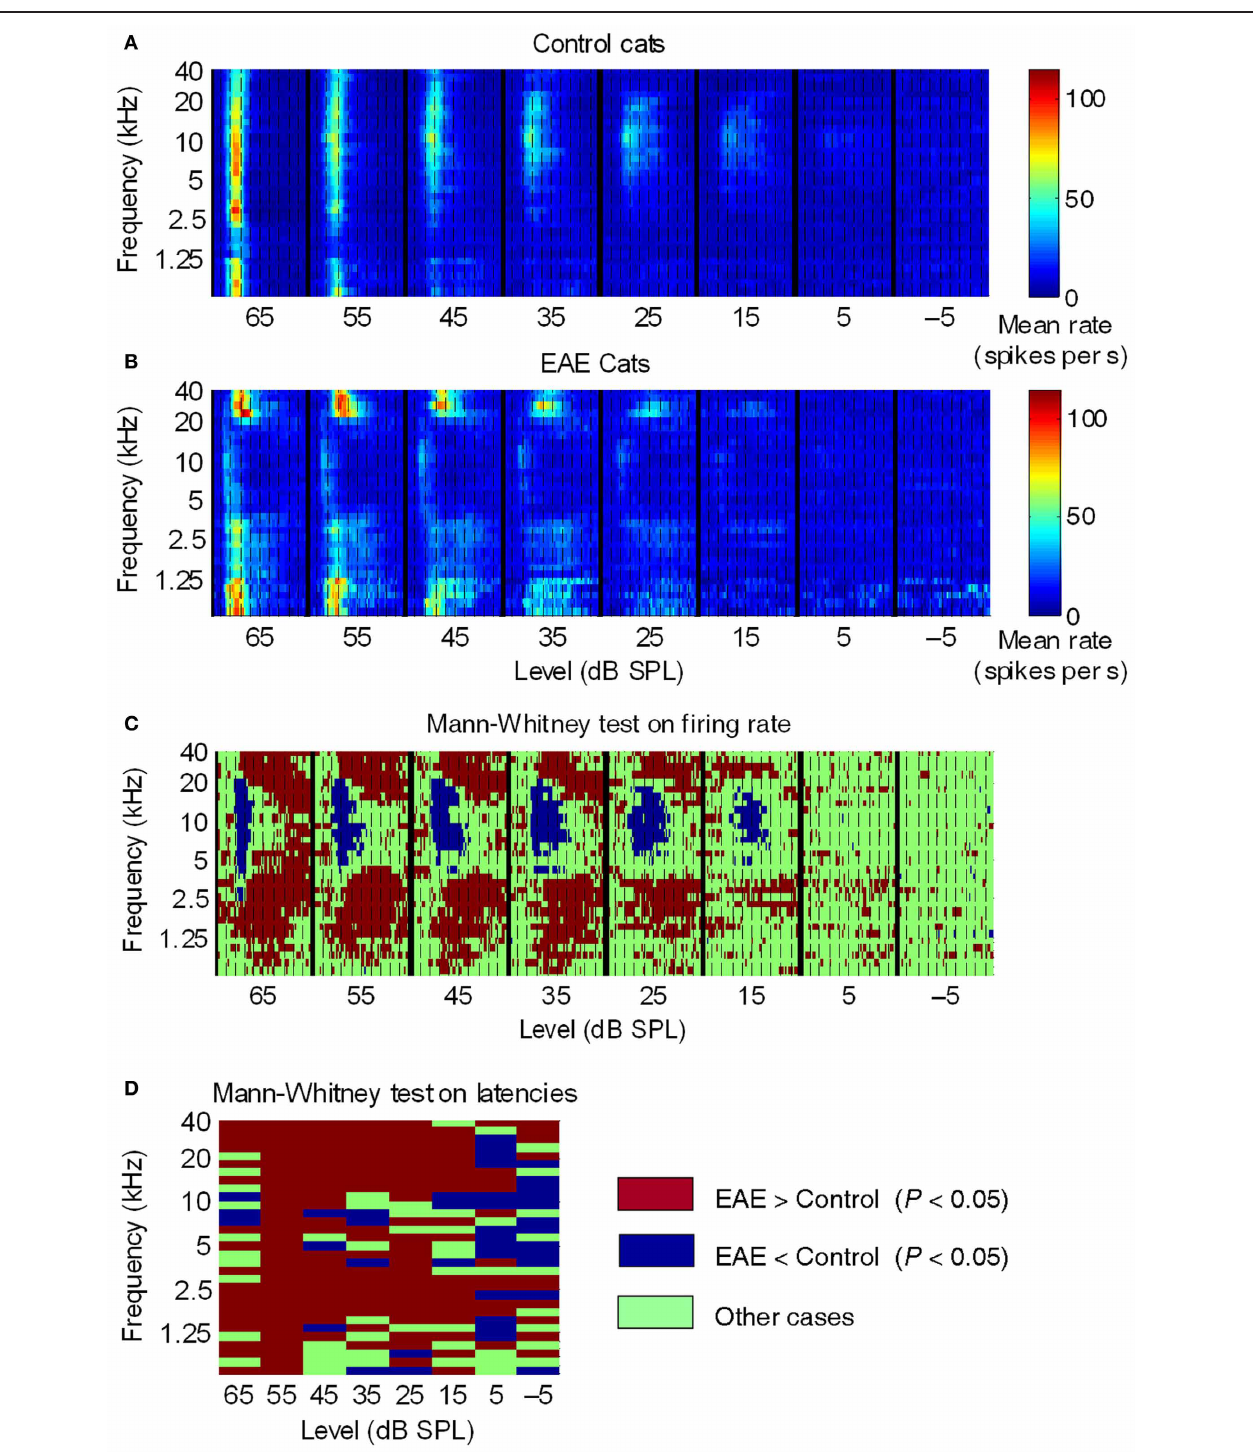
and 10kHz. In EAE cats (B) , the most sensitive frequencies were those below 1.25kHz and above 20kHz. Note that neural responses in EAEcats were much more spread out over time compared to those in control cats. (C,D) Graphical representation of significant differences (Mann-Whitney test) between EAE and control groups in terms of (C) mean firing rate per frequency-latency bin and (D) mean latency per frequency-intensity bin. From Noreña et al.